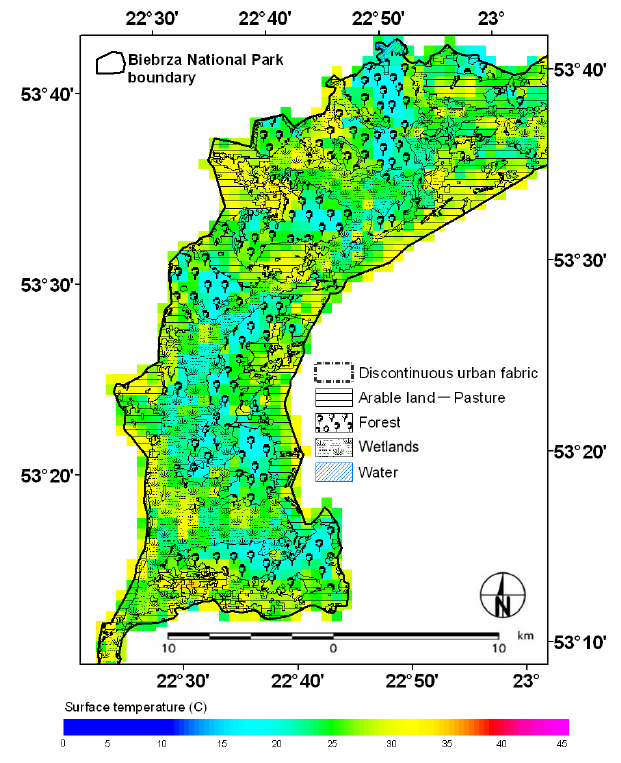
Figure 13. Surface temperatures at the test site at the turn of April/May 2003 (dry